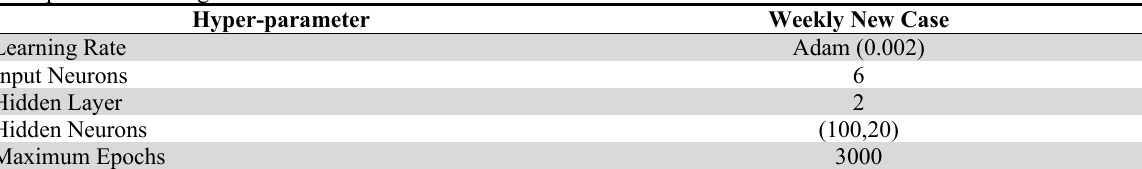
MLP parameter setting Hyper-parameter Weekly New Case Learning Rate Hidden Neurons Maximum